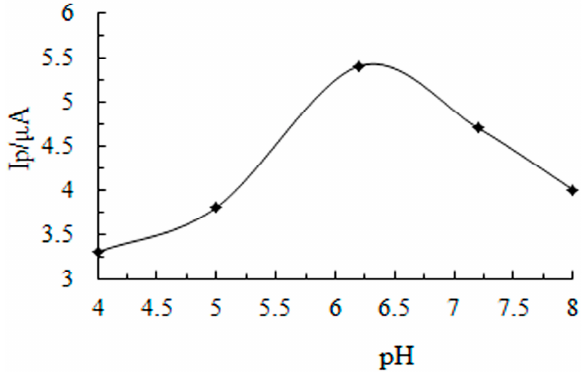
Figure 6. Influence of buffer solution pH to peak current.